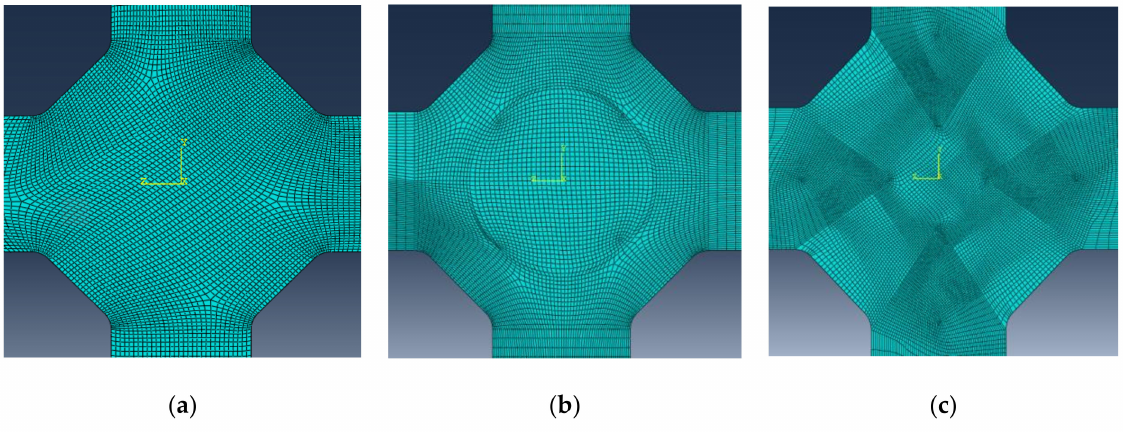
Figure 7. View of the samples after the meshing procedure: ( a ) Specimen_0, ( b ) Specimen_1, ( c )